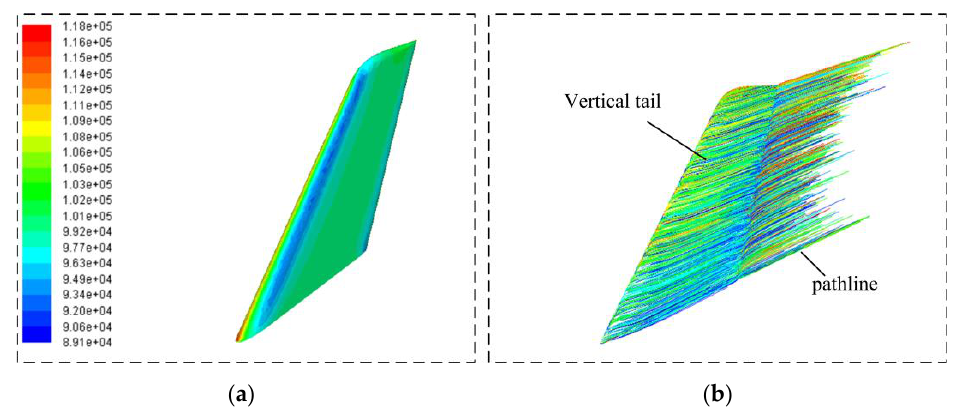
Figure 10. Aerodynamic analysis: X t = 2.5 m; V ∞ = 125.8 m/s; ( a ) Static pressure (Pa); ( b ) Path line.